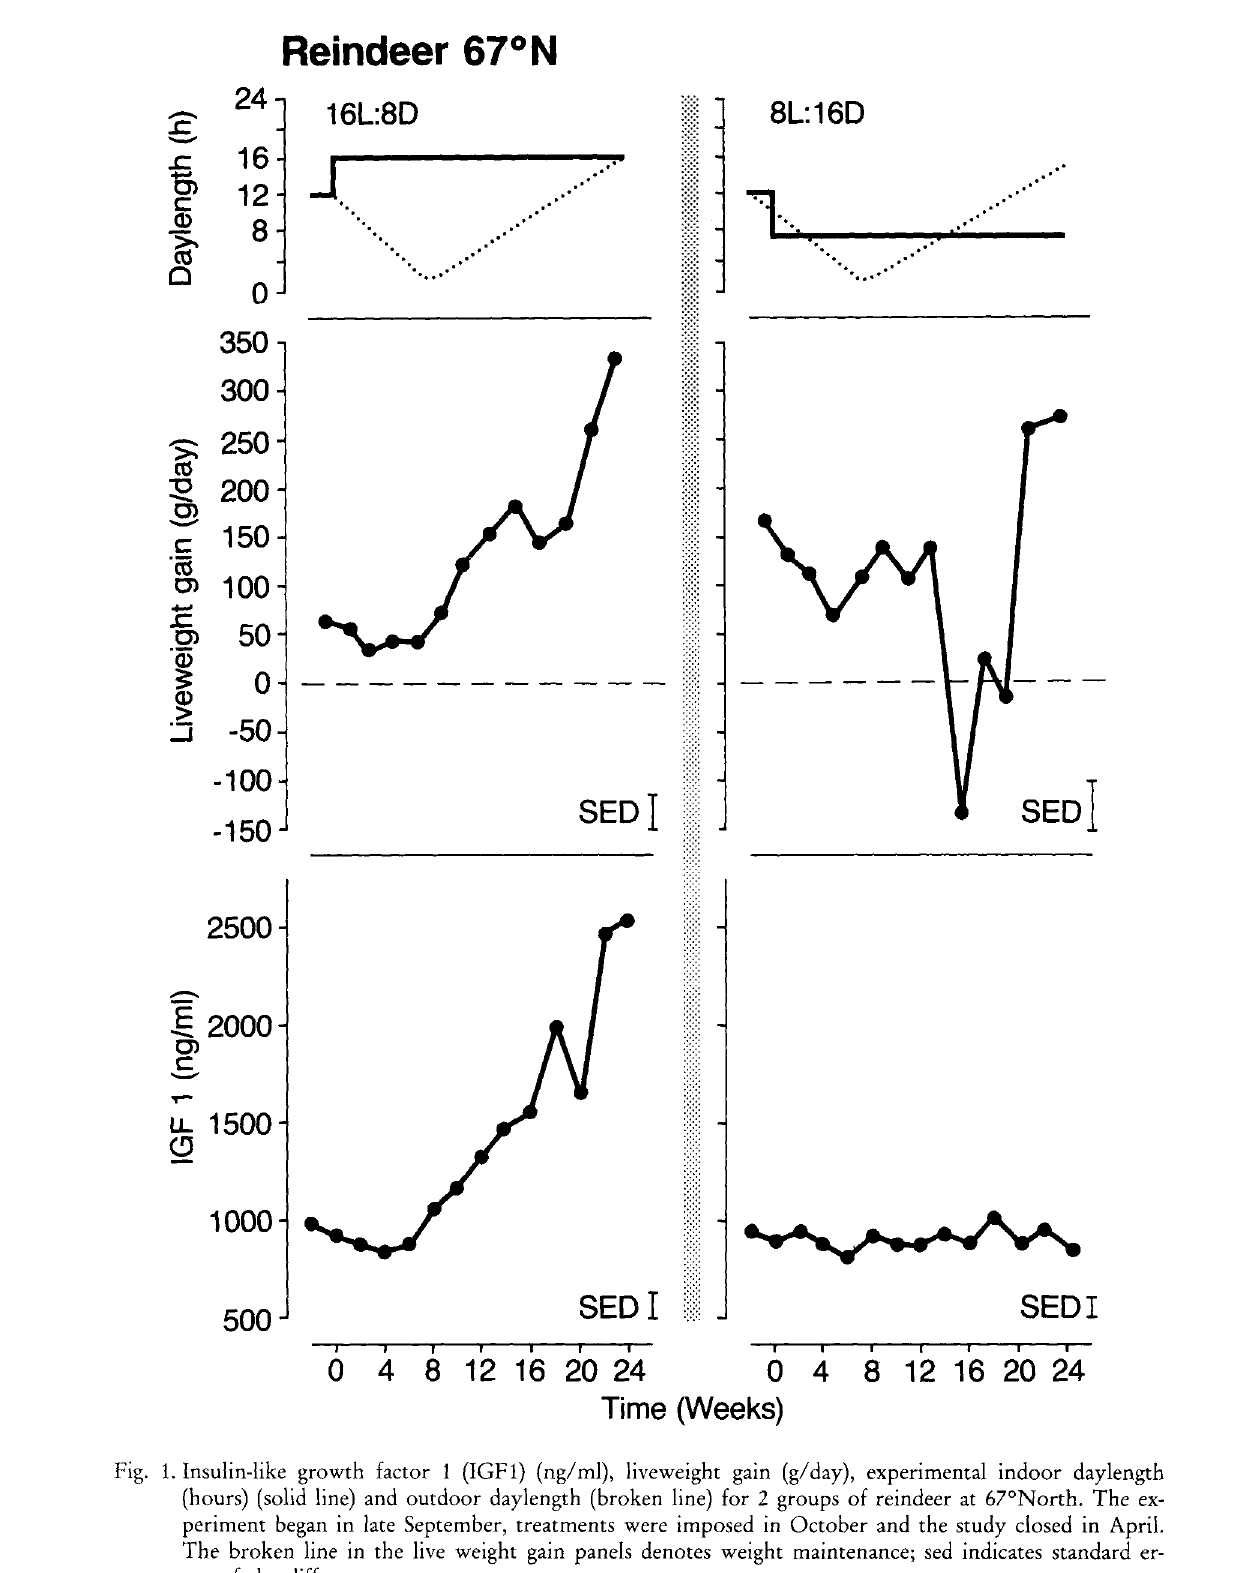
Fig. 1. Insulin-like growth factor 1 (IGF1) (ng/ml), liveweight gain (g/day), experimental indoor daylength (hours) (solid line) and outdoor daylength (broken line) for 2 groups of reindeer at 67°North. The ex periment began in late September, treatments were imposed in October and the study closed in April. The broken line in the live weight gain panels denotes weight maintenance; sed indicates standard er ror of the